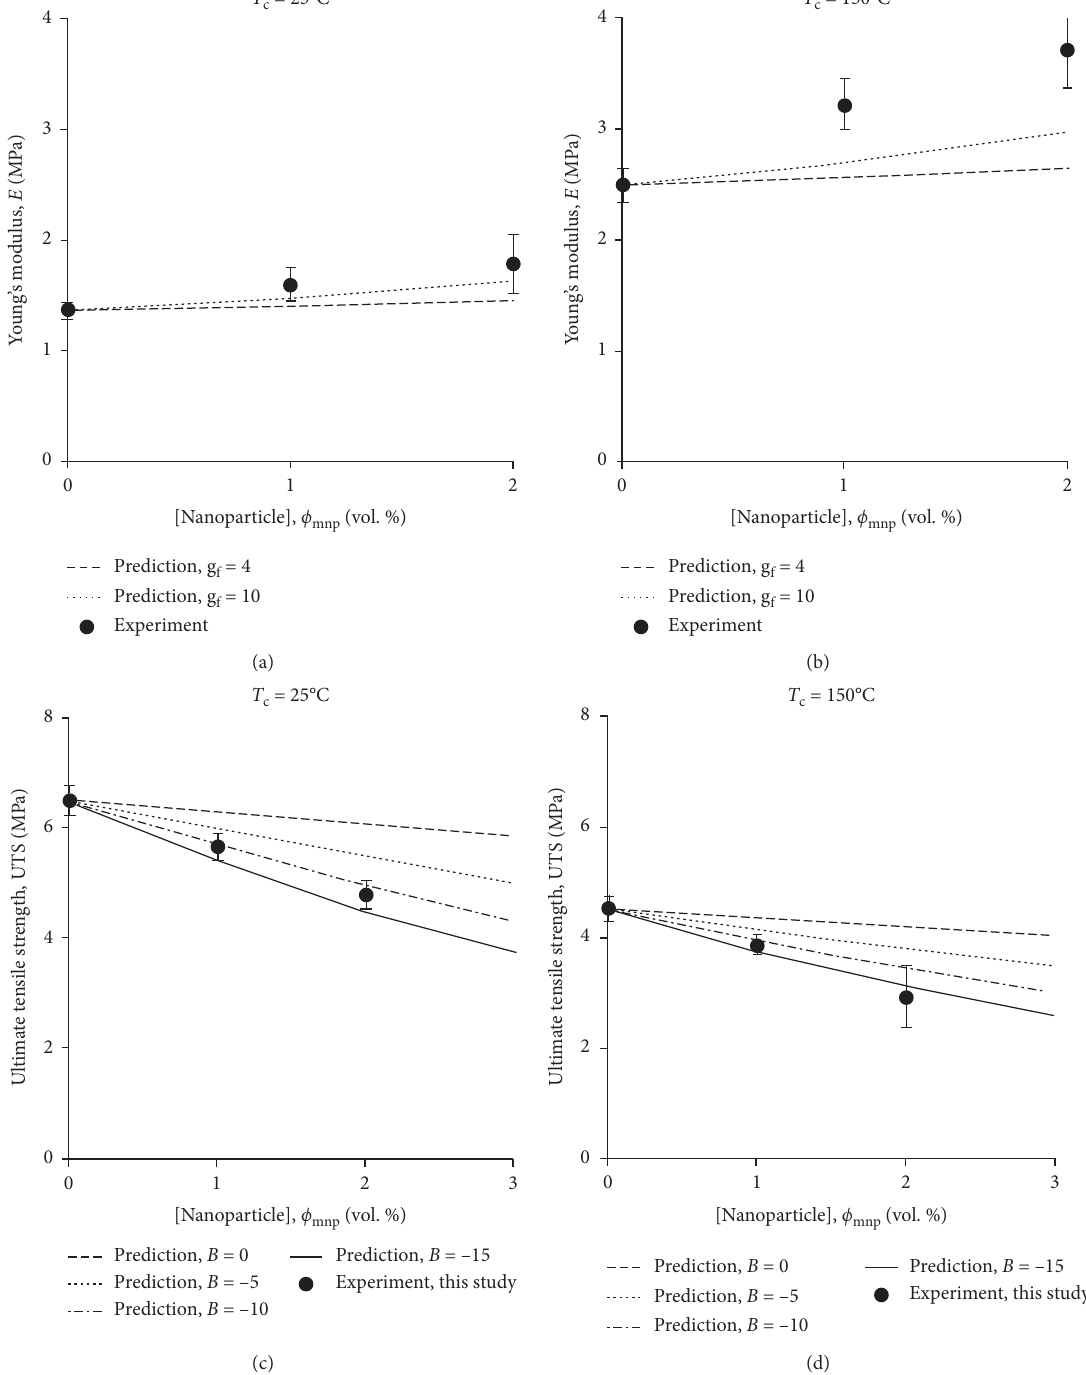
Figure 5: Predictions vs. experiments. Young’s modulus (a, b) and ultimate tensile strength (c, d) as functions of the volume fraction of , at curing temperatures 25 ° C and 150 ° C. Dashed and dotted lines represent the theoretical values calculated using Guth model (a, MNP, ϕ mnp b) when factor g is equal to 4 and 10, respectively, and Turcsanyi model (c, d) when factor B is equal to 0 and − 10, respectively. Black dots f represent experimental values, corresponding to samples MNP-0, MNP-1, and MNP-2 from left to